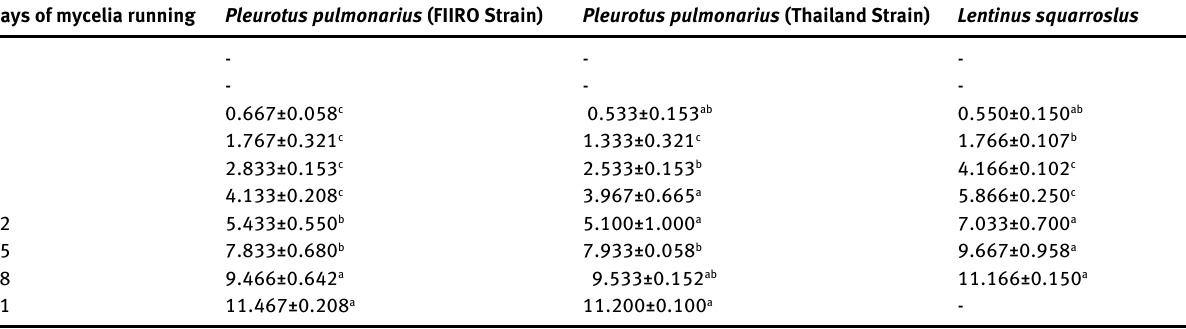
Values with different superscript across the columns are significantly different